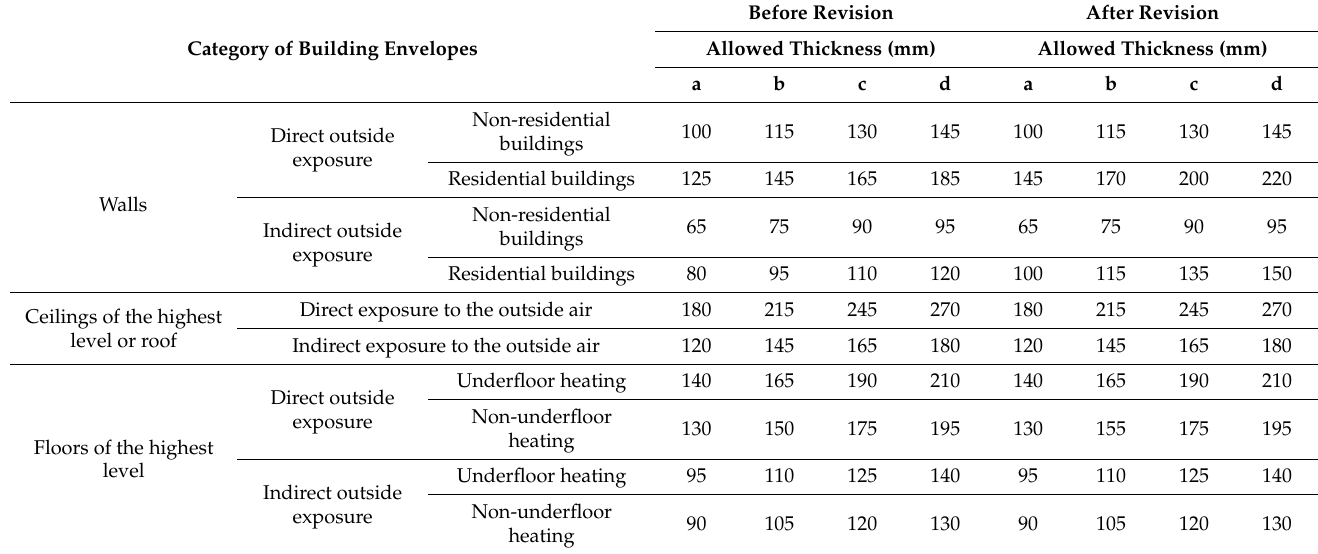
Table 2. 2017 revision of the building insulation thickness standard for the southern region